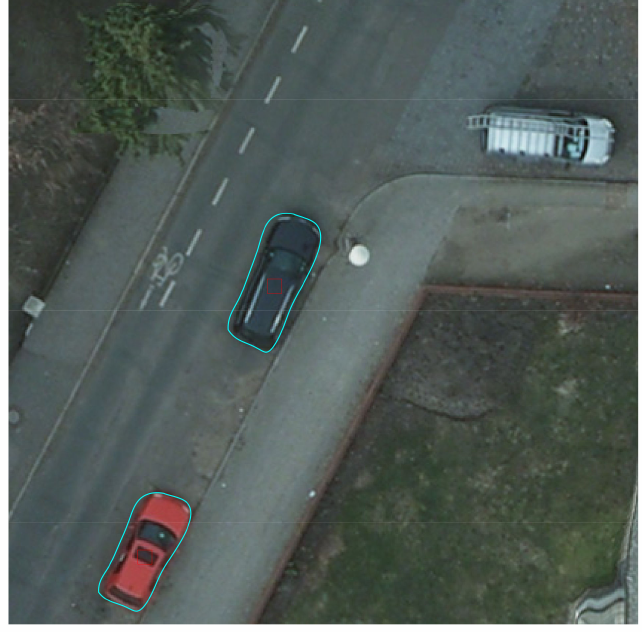
Figure 2. Illustration of